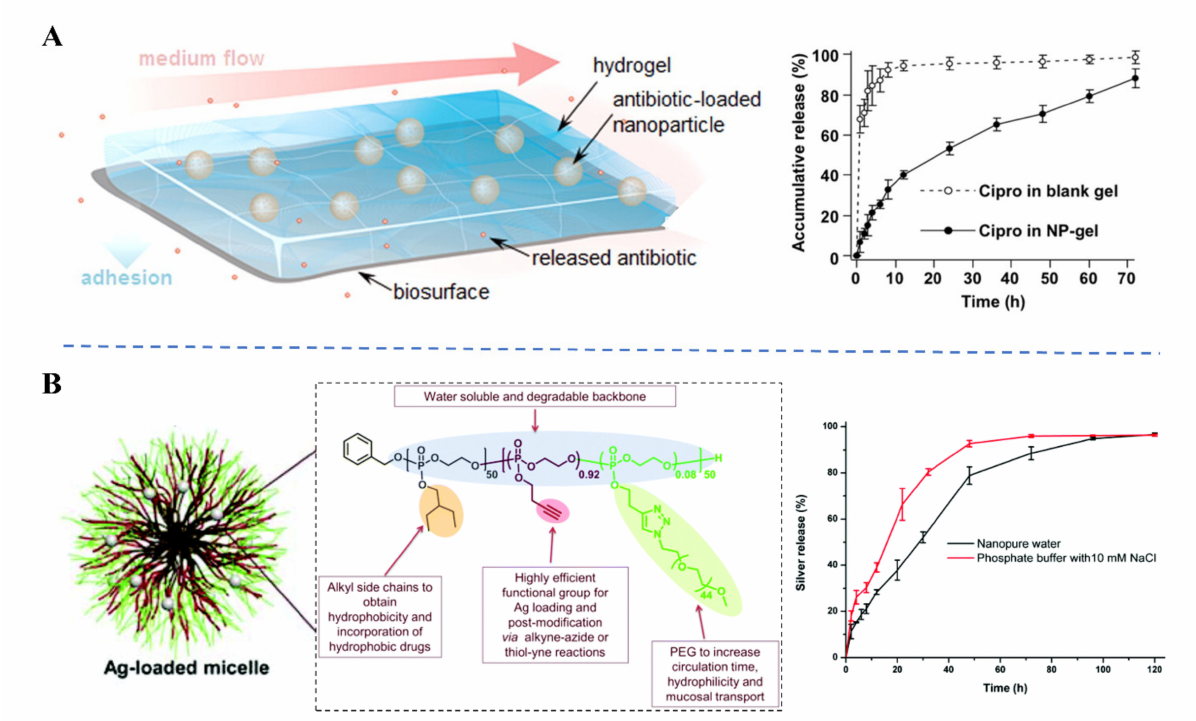
Figure 3. Examples of extended-release antimicrobial delivery systems based on polymeric nanocarriers. ( A ) (Left) Schematic illustration of tissue-adhesive nanoparticle–hydrogel hybrid (PLGA NP-gel) biomaterial system for sustained antibiotic release. (Right) The accumulative release profile of antibiotic Ciprofloxacin (Cipro) from Cipro-loaded PLGA NP-gel and Cipro-loaded blank gel without PLGA NPs in PBS buffer (adapted with permission from [38], copyright 2016 ACS). ( B ) (Left) Overall design of the degradable amphiphilic block terpolymer for assembly into NPs capable of silver-based antimicrobial delivery. (Right) Sustained-release profiles of silver cations from the NPs at 37 ◦ C in pure water and PBS buffer (reproduced with permission from [40], copyright 2015 Royal Society of